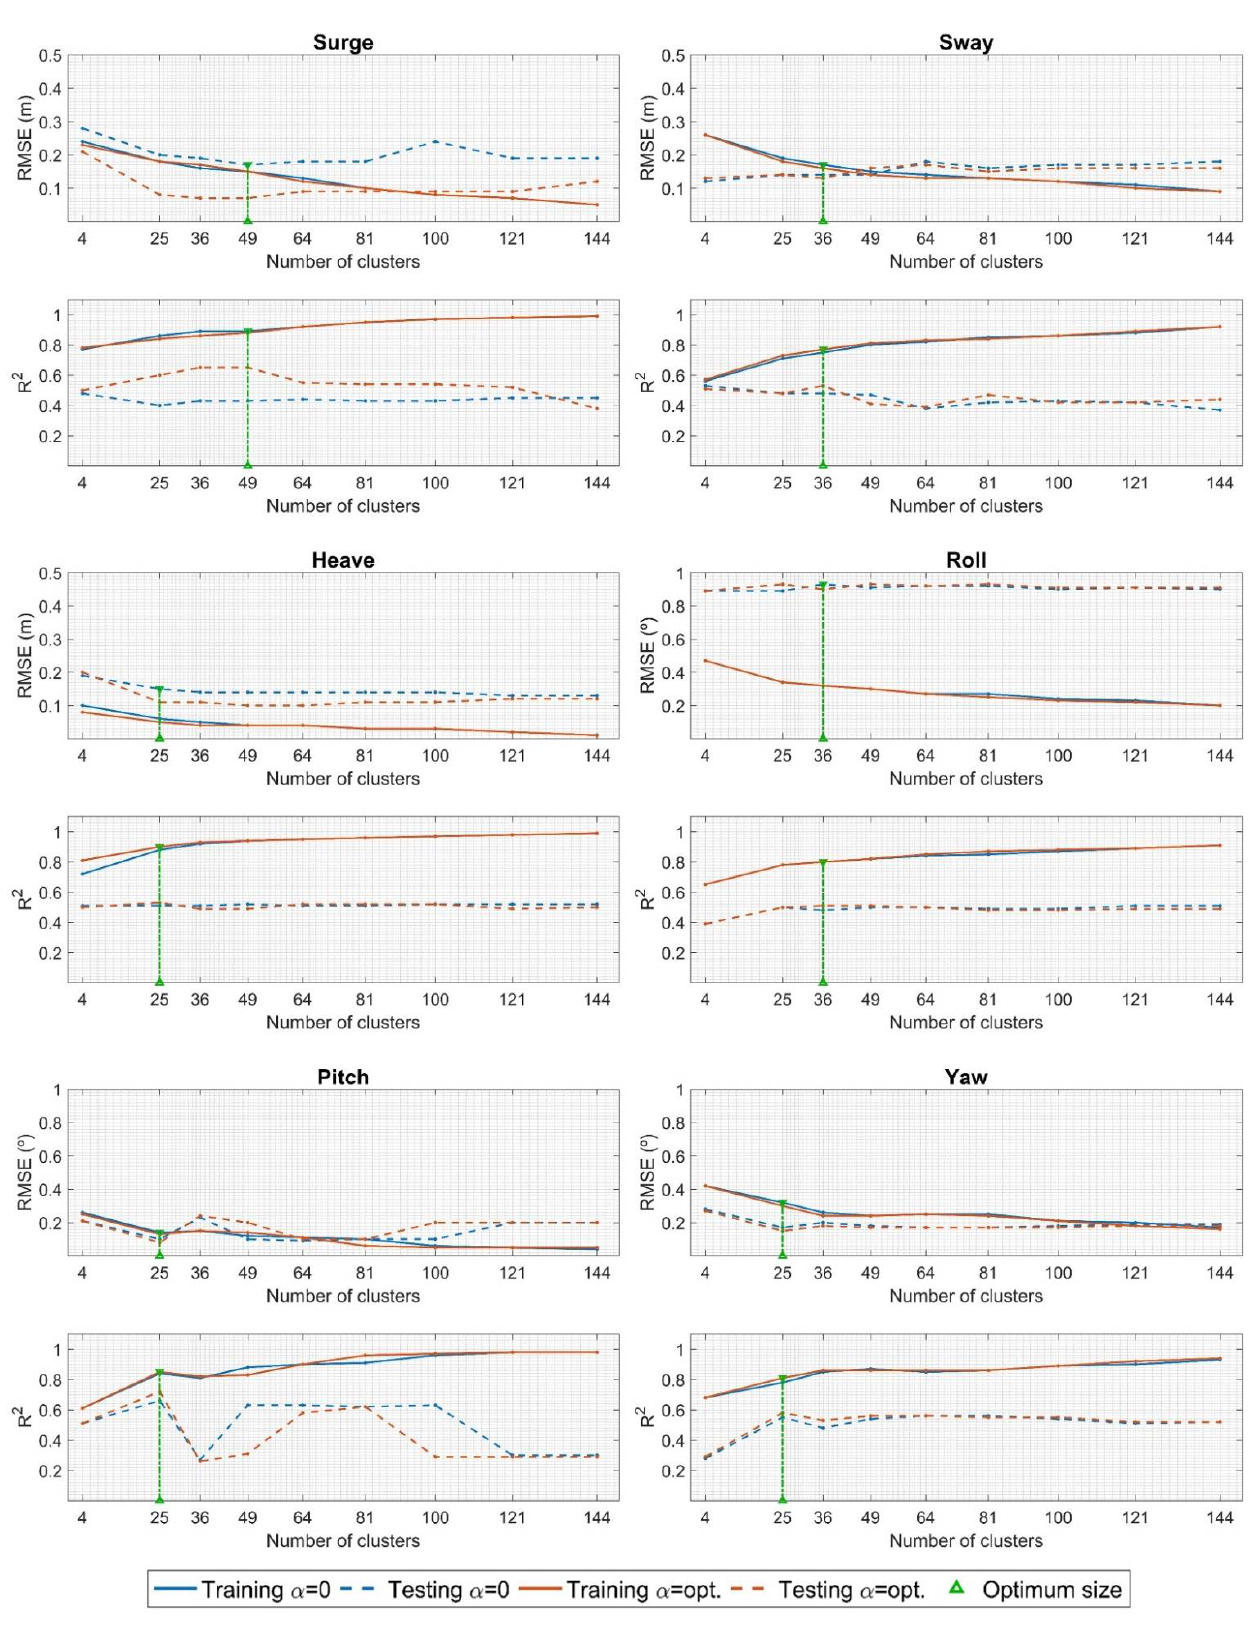
Figure 3. Evaluation of the results from the prediction model for the six DoF, in terms of RMSE and R 2 , for α = 0 (blue color) and α = optimum value (orange color), for different clustering sizes. Solid line: verification of the results after the training phase; dashed line: results validation in testing